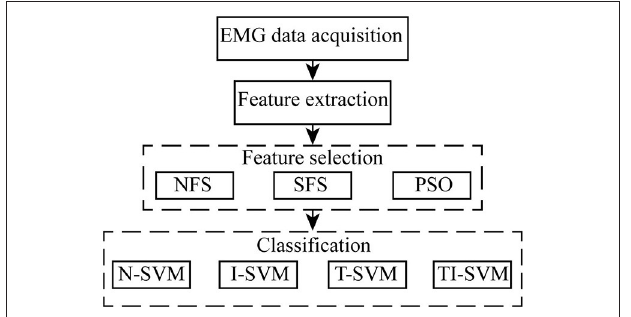
FIGURE 1 | Schematic illustrating the optimization process in this study.